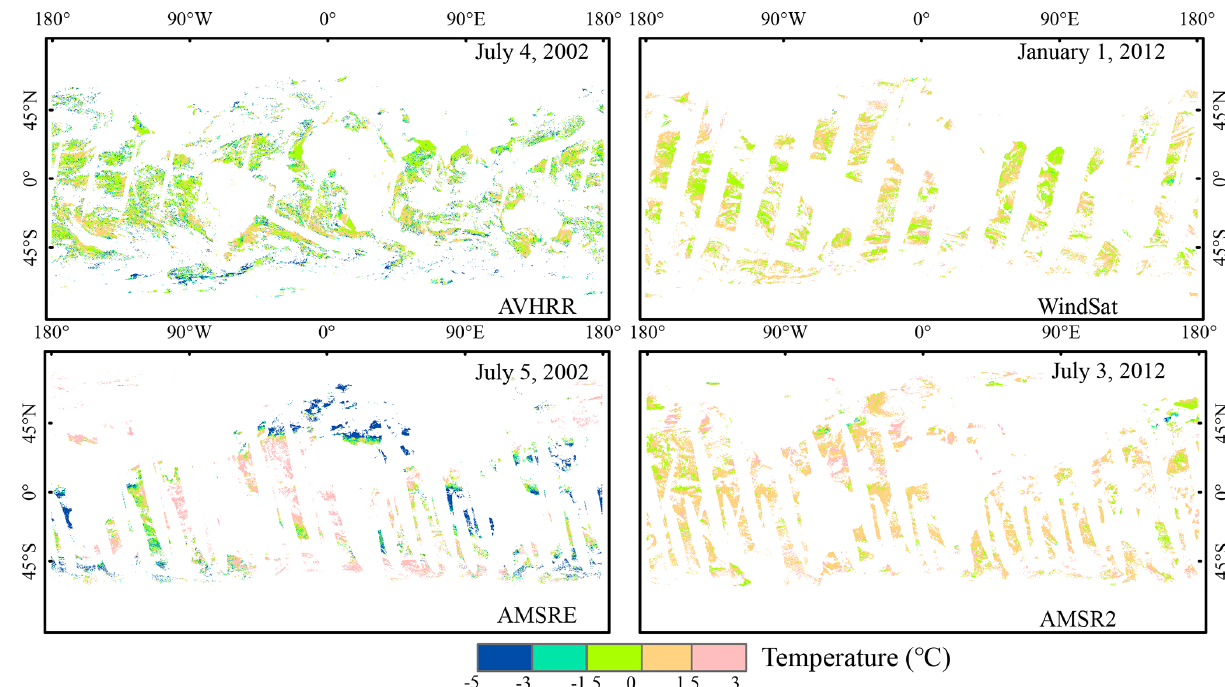
Figure 3. Difference maps of the original MODIS and multisource daily SST products. Areas of missing data are blank.